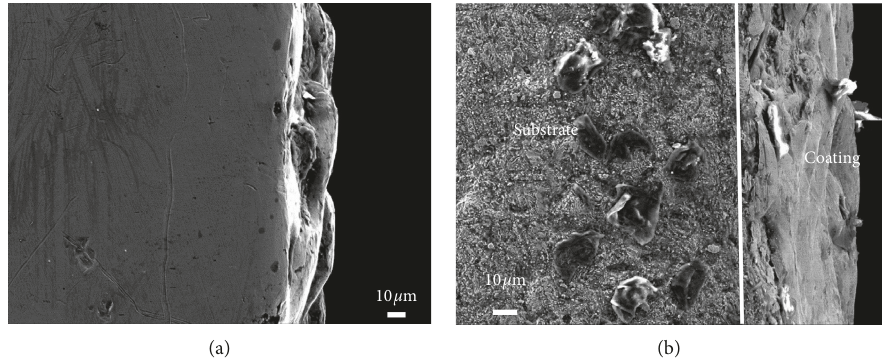
Figure 4: (a) SEM images of the coating cross section and (b) after etching with 98%.vol sulfuric acid.